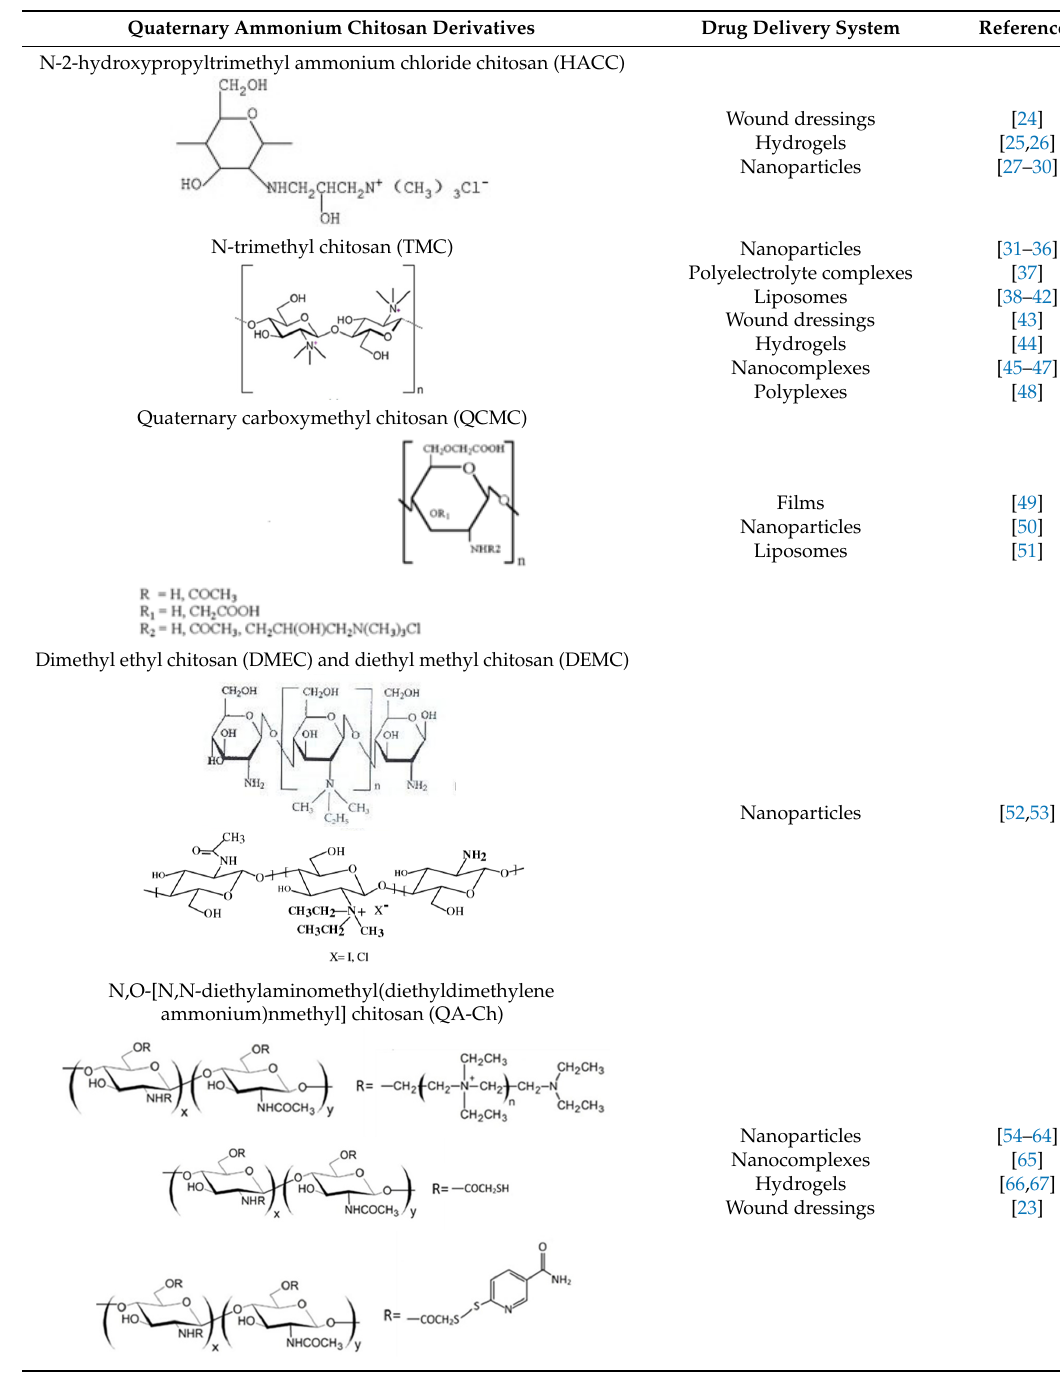
Table 1. Overview of drug delivery systems based on quaternary ammonium chitosan derivatives.